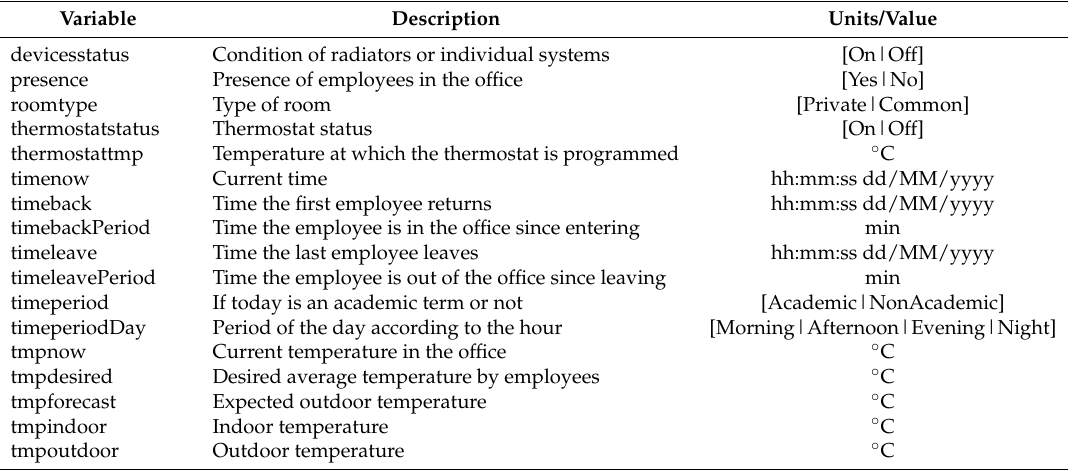
Table 1. Summary of algorithm